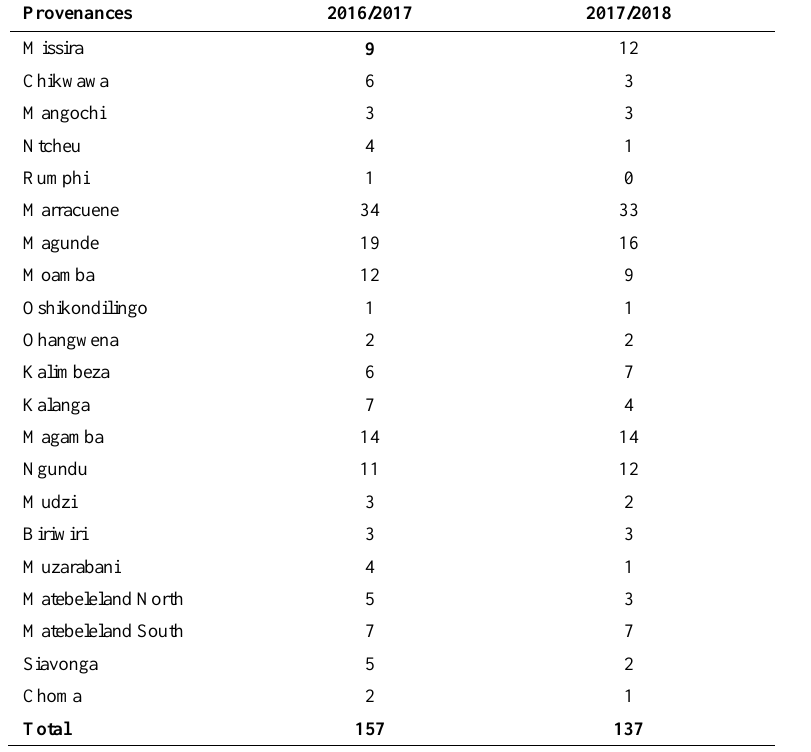
Table 3. Total number of fruiting trees per provenance in 2016/2017 and 2017/2018 seasons Provenances